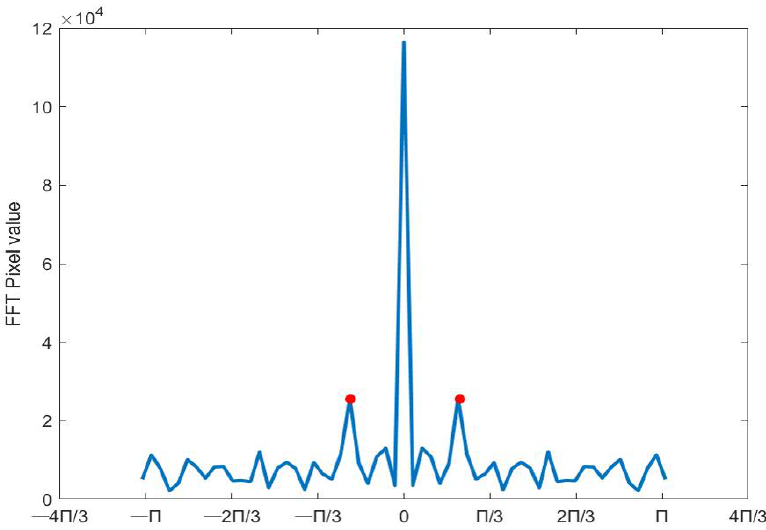
Figure 4. The frequency spectrum curve of the above data in Figure 3.